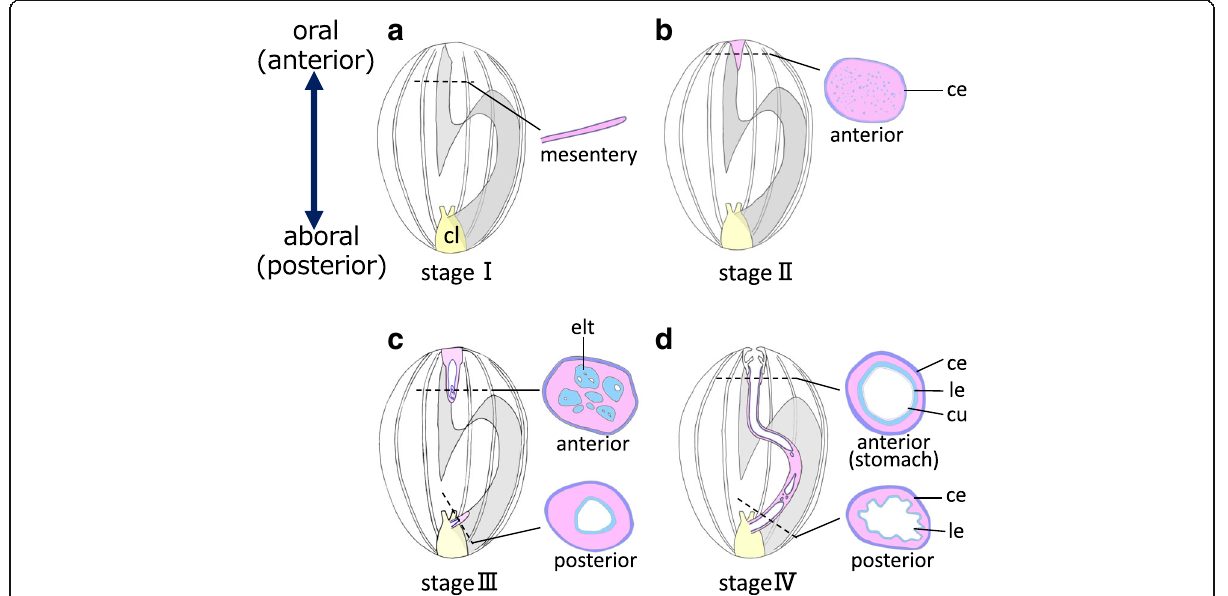
Fig. 9 Schematic diagram of regeneration of the digestive tube. The internal structure of dissected animals and cross sections at the positions of the dotted lines are illustrated. Organs other than the mesentery and the digestive tract are ommited. a Stage I, just after evisceration. Only the mesentery (gray shaded area) and the cloaca (cl; yellow) remain in the body cavity. b Stage II. A regenerating tissue (gut rudiment) appears at the anterior side as a mass of mainly mesenchymal cells surrounded by coelomic epithelium. c Stage III. Multiple cavities are formed in the anterior regenerating tissue and these coalesce with each other to form lumens. d At stage IV when regeneration is more progressed, the gut rudiment (thickened tissue on the mesentery) becomes continuous between the anterior and posterior sides. The figure shows that the anterior and posterior lumens are not yet connected, but later a single continuous tube is completed. Intestines differentiate according to their position in the digestive tract. In the stomach, a muscle layer (not shown) develops and luminal epithelium (le) is covered with cuticles (cu), as in intact tissues (see Fig. 4a, d). ce: coelomic epithelium; cl: cloaca; cu: cuticles; elt: epithelium-like tissue; le: luminal